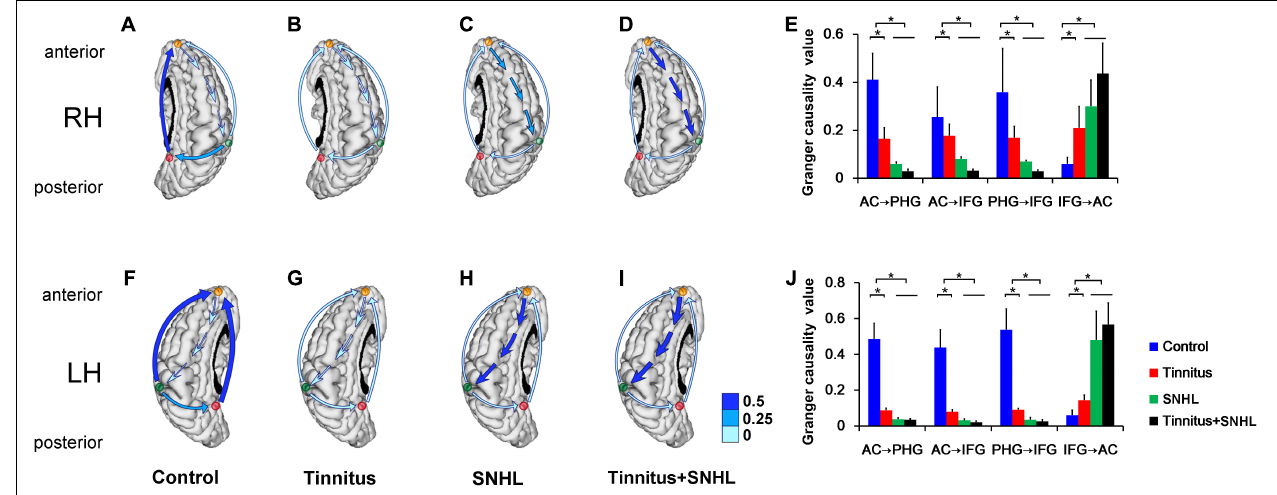
FIGURE 3 | (A–D) The right brain of the control group, right-ear tinnitus group, right-ear SNHL group and right-ear tinnitus/SNHL group, respectively. (E) Comparison of the functional connectivity of the AC, PHG, and IFG between right-ear tinnitus, SNHL and control subjects. (F–I) The left brain of the control group, left-ear tinnitus group, left-ear SNHL group and left-ear tinnitus/SNHL group, respectively. (J) Comparison of the functional connectivity of the AC, PHG, and IFG between left-ear tinnitus, SNHL and control subjects. The green, red and orange dots represent the AC, PHG, and IFG, respectively. The blue arrow represents connectivity. RH, Right cerebral hemisphere; LH, Left cerebral hemisphere. * P <